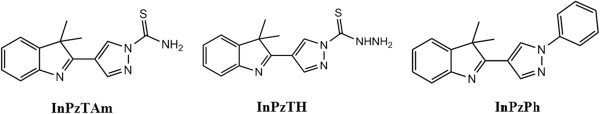
Molecular structure of the pyrazolylindolenine compounds.